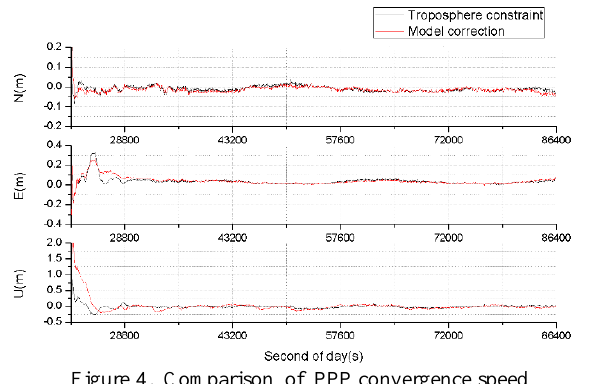
Figure 3. Comparison of ZWD value between grid interpolation and PPP calculation